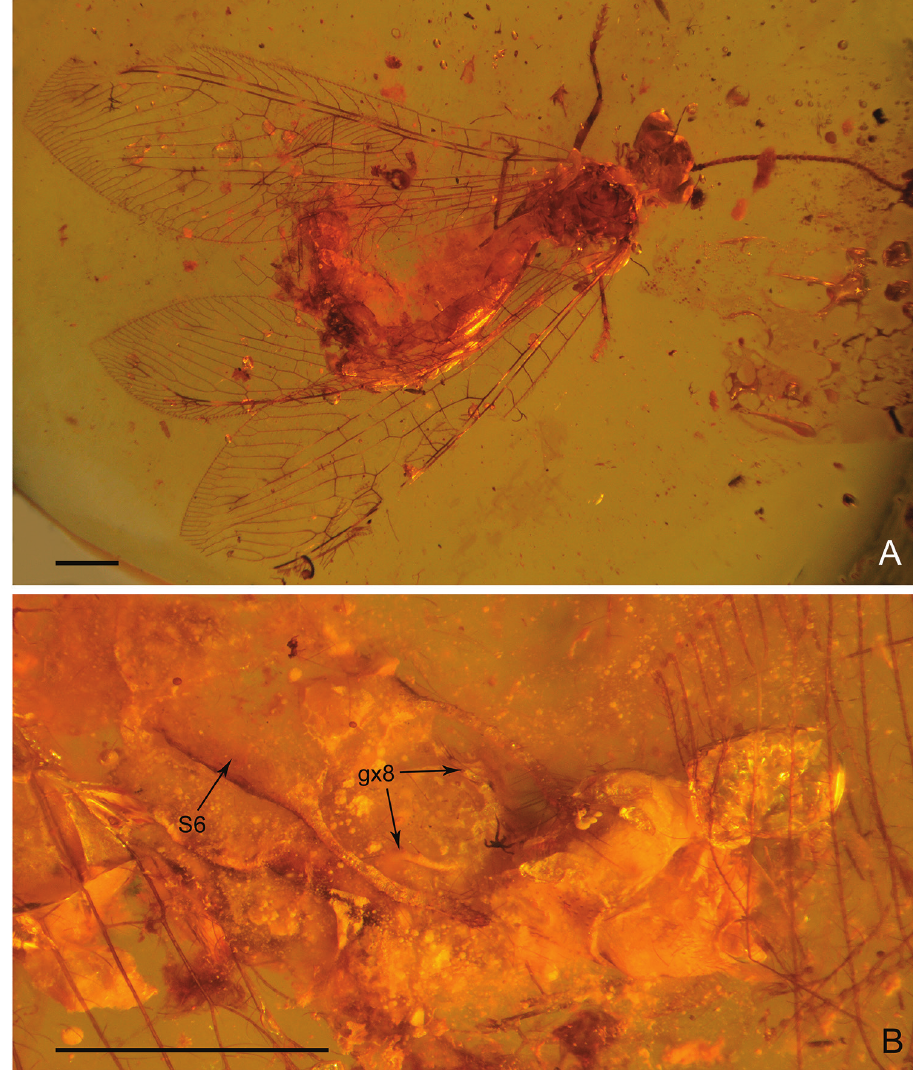
Figure 6. Electrobabinskaia burmana Lu, Zhang & Liu, 2017, female. A Habitus photograph, dorsal view B Photograph of abdomen, ventral view. Abbreviations: S: sternum; gx: gonocoxite. Scale bars: 1.0